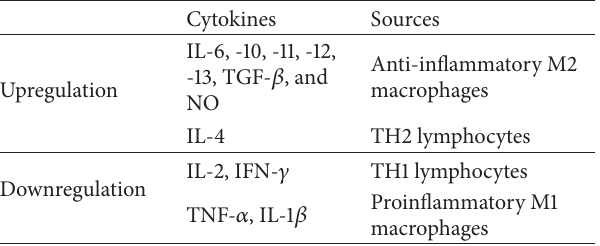
Table 1: Immune impact of mesenchymal stromal